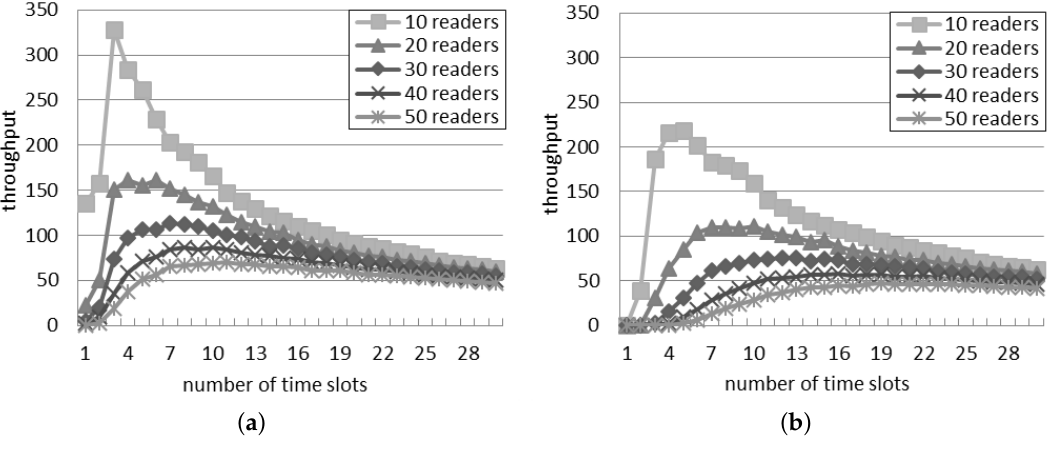
Figure 6. Throughput in the slotted interrogation scenario. ( a ) Single interference model; ( b ) Additive interference